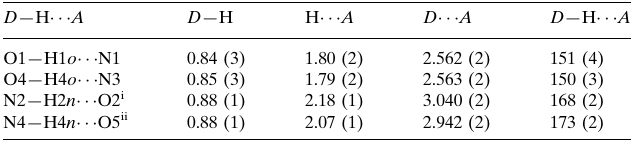
Hydrogen-bond geometry (A˚ , (cid:2)